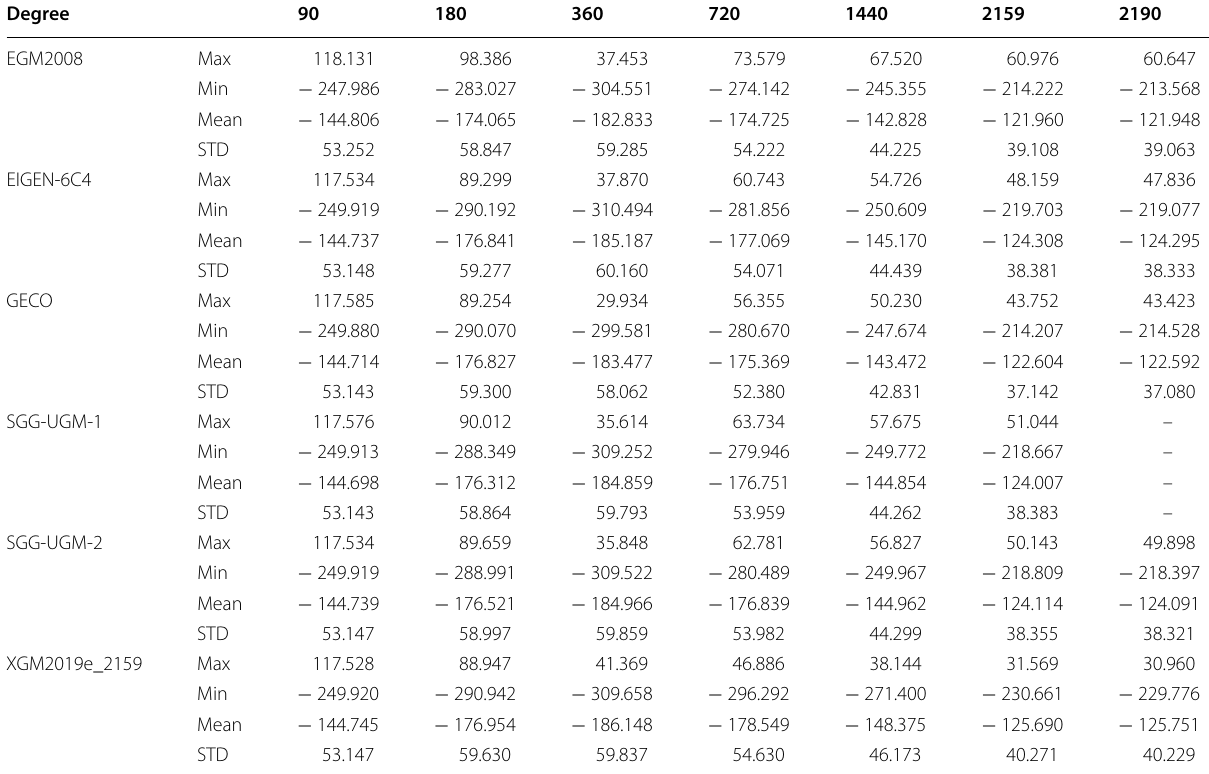
Table 2 The statistics of the differences between the gravity anomaly derived from gravity field models and the measured data in plateau area (unit: mGal) Degree 90